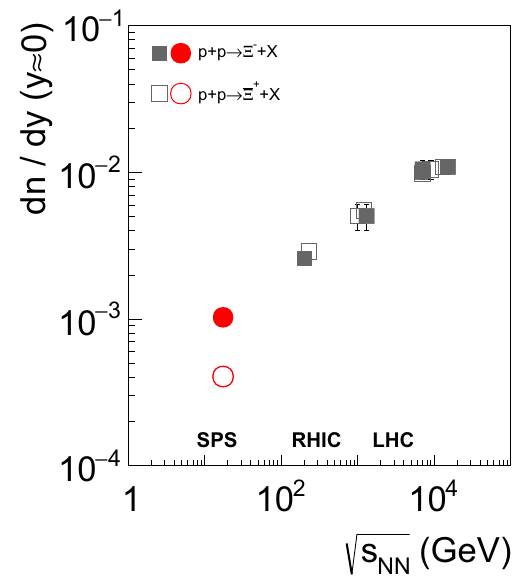
Fig. 6 Mid-rapidity densities (dn/d y ) of (cid:2) − (full symbols) and (cid:2) + (open symbols) measured in inelastic p+p interactions as a function of √ s NN . The systematic and statistical uncertain- centre-of-mass energy ties are smaller than the symbol size. The data are compared to results √ s NN = 200 GeV [17], from from STAR at the BNL RHIC measured at √ s NN = 0.9, 7 and 13 TeV [18– ALICE at CERN LHC measured at √ s NN = 0.9 and 20] and from CMS at the CERN LHC measured at 7 TeV [21]